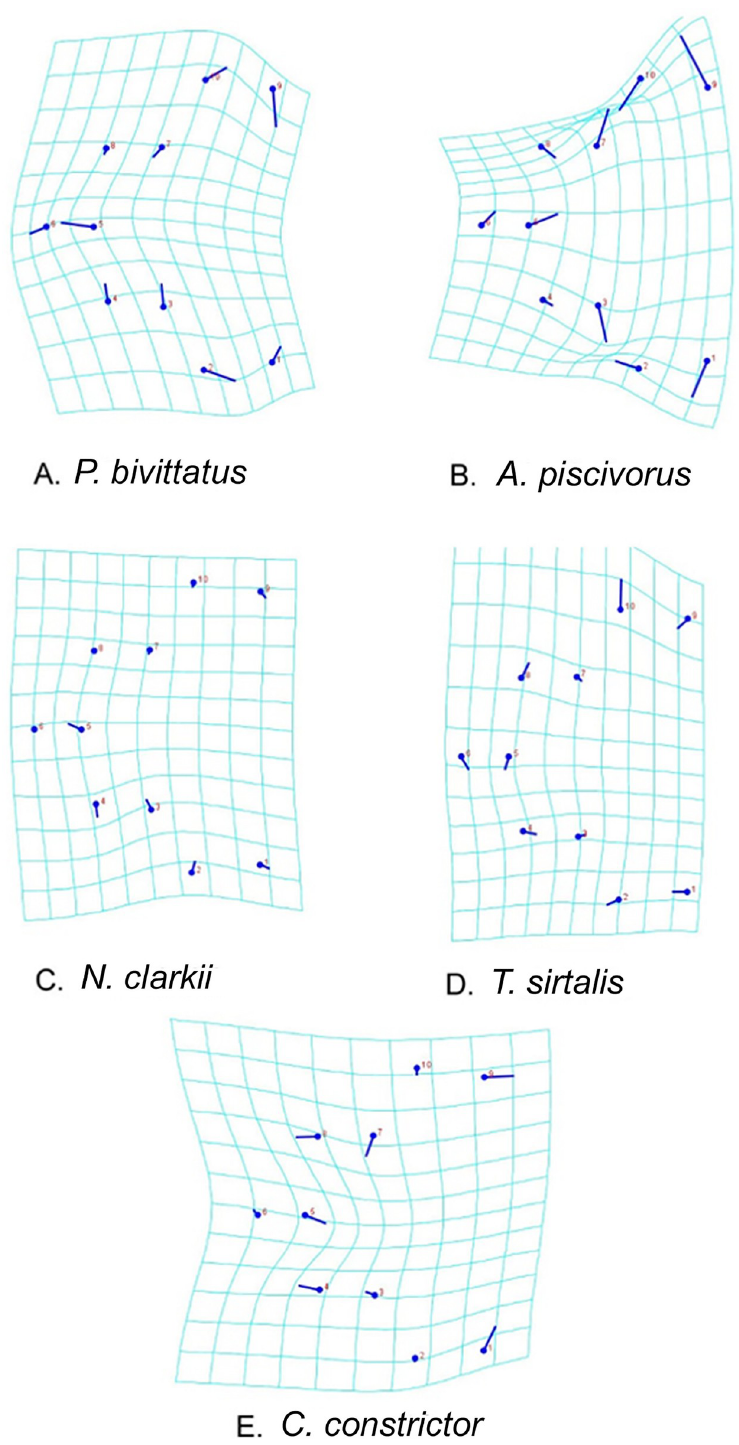
Fig 3. Transformation grids showing host-specific changes in hook and oral cadre morphology of Raillietiella orientalis . Morphological variation of R . orientalis among host species is shown by lines originating from a circle. Circles indicate the position of the average specimen. The direction of the line relative to a circle indicates specific variation in morphology among species relative to a consensus